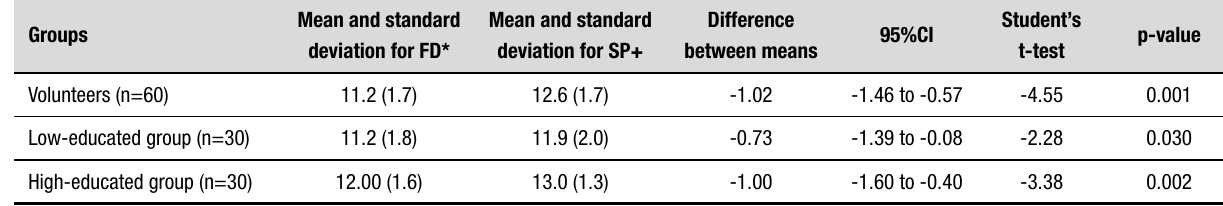
Table 2. Comparison of verbal agility performance of Federal District volunteers with Brazilian normative mean values for São Paulo. Groups